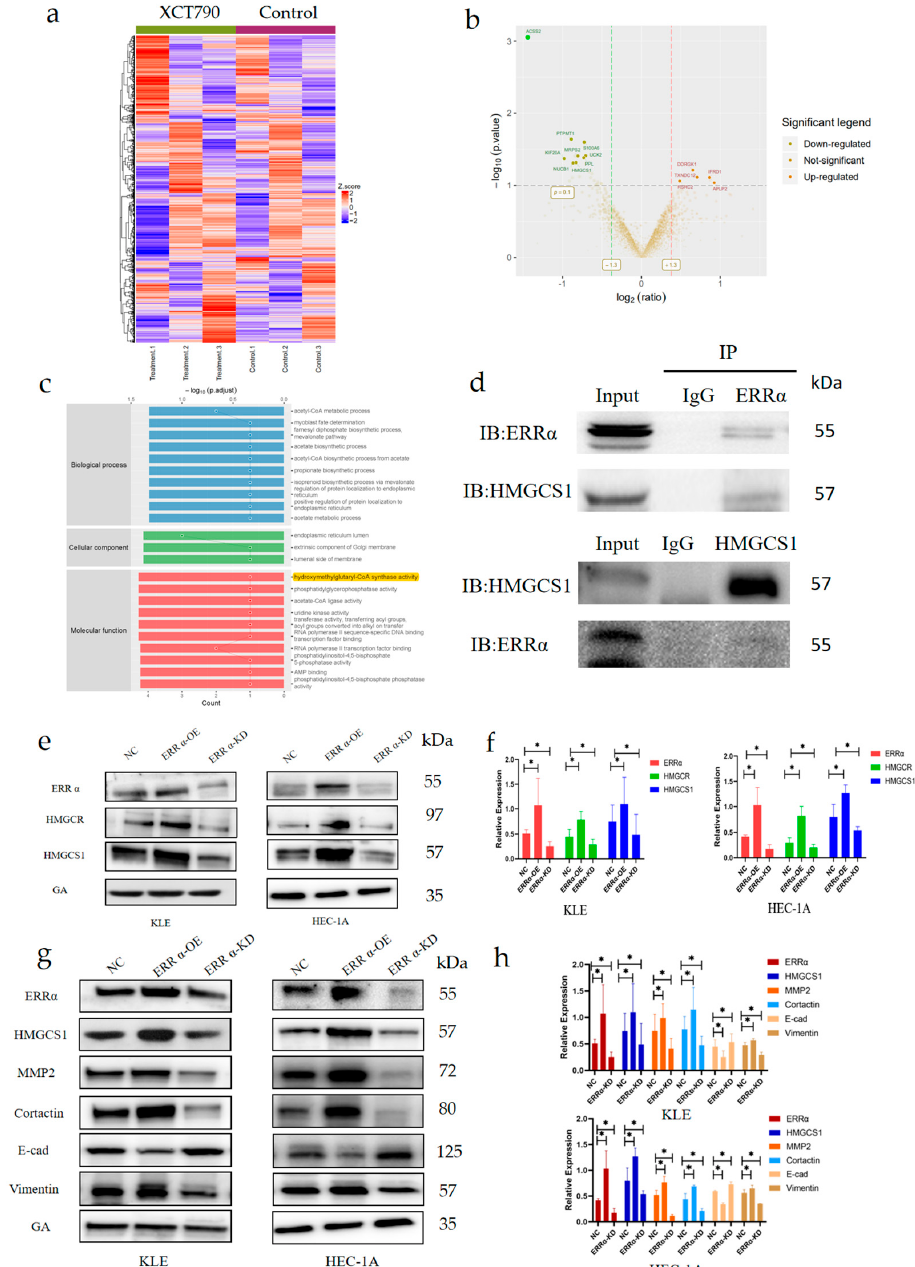
Figure 4. ERR α facilitates the membrane fluidity of EC cells due to the effects of HMGCS1 on EMT signaling. ( a ) After comparing untreated EC cells and EC cells treated with 10 µ M XCT790 for 24 h (EC XCT790 ) by proteomics, proteins related to ERR α were identified by hierarchical cluster analysis. ( b ) Volcano plots of the 14 proteins significantly correlated with ERR α . The x-axis is the log 2-fold change (FC), and the y-axis is the − log 10 ( p -value). ( c ) Gene Ontology annotation classification analysis of proteins associated with ERR α down-regulation, the proteins were classified according to biological process (BP), cellular component (CC), and molecular function (MF). ( d ) Co-immunoprecipitation verified that ERR α and HMGCS1 interact with each other. ( e , f ) The expression levels of HMGCR and HMGCS1 after ERR α up- and down-regulated in EC cells and the statistical analysis results. ( g , h ) The effect of ERR α and HMGCS1 on the expression levels of EMT-related and membrane fluidity biomarkers, E-cadherin (E-cad), vimentin, matrix metalloproteinase 2 (MMP2), and cortactin after ERR α and HMGCS1 up- and down-regulation in EC cells, and the statistical analysis results. *, indicates statistical significance. Statistical tests: Student’s t -test or